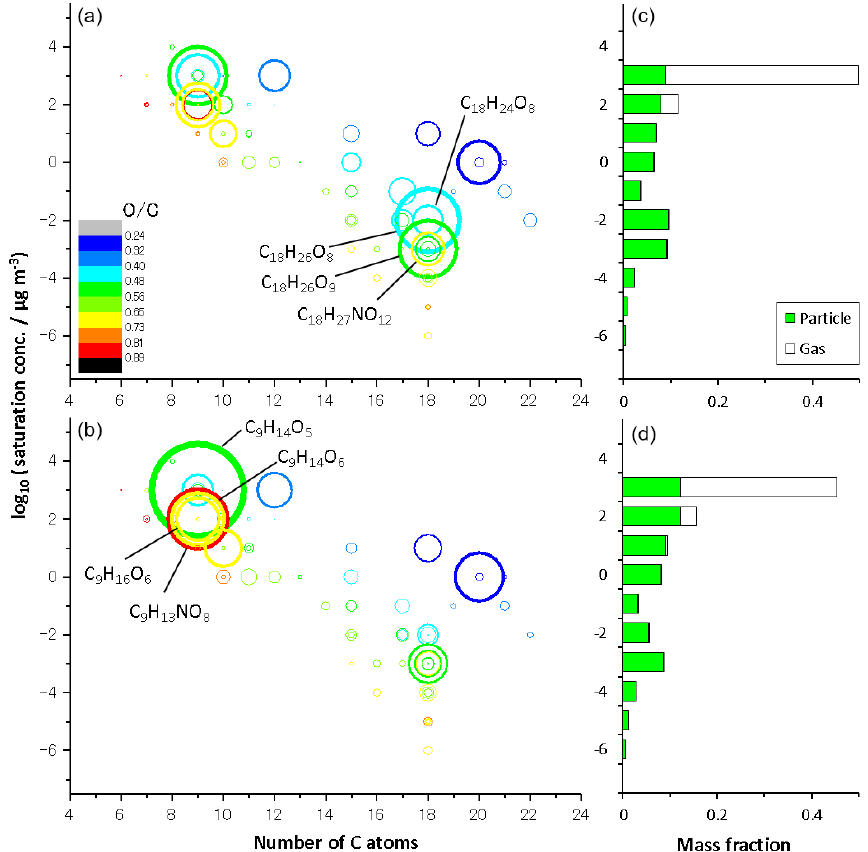
Figure 3. Volatility versus carbon number mapping obtained from LC-TOF-MS results for particulate products in (a) normal photooxidation (run 1) and (b) aging experiments (run 2), and the volatility distribution determined for the sum of gaseous and particulate products in (c) normal photooxidation (run 1) and (d) aging experiments (run